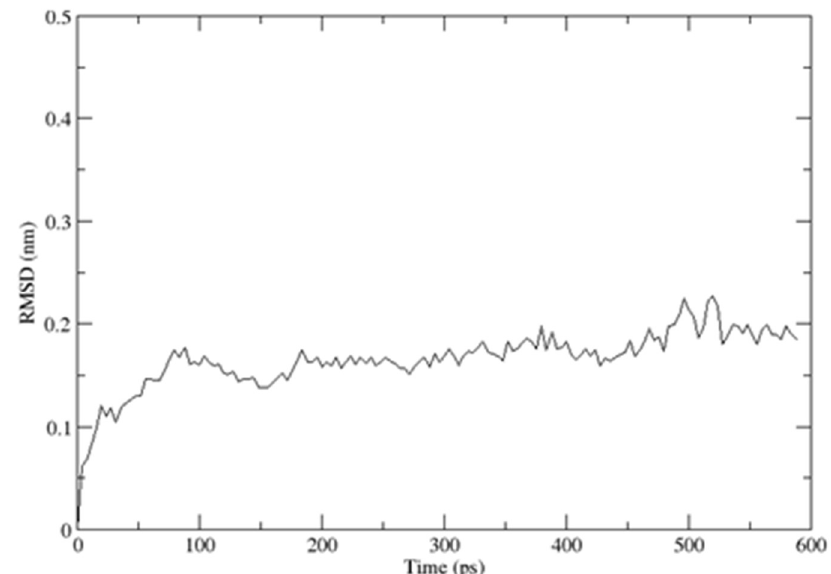
Figure 14. Distribution of backbone’s RMSD deviation during the molecular dynamic simulation of the CUBAN/NEDD8 complex during time indicated in pico seconds (ps).